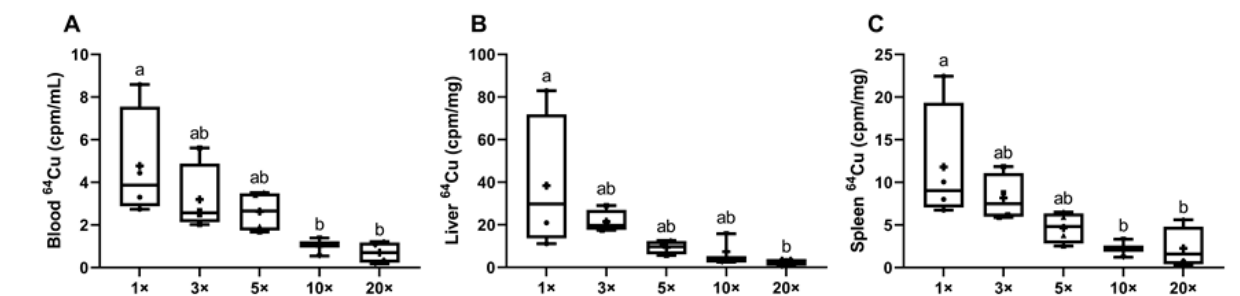
Figure 6. 64 Cu accumulation in blood, liver, and spleen were reduced in pups suckling dams that consumed diets with iron content in excess of requirements. 64 Cu activity in blood ( A ), liver ( B ), and spleen ( C ) from pups at 13–15 days of age suckling dams that consumed diets varying in iron concentration for ~3.5 weeks. One-way ANOVA analysis results are as follows: blood 64 Cu ( A ), p = 0.0153; liver 64 Cu ( B ), p = 0.0357; and spleen 64 Cu (C), p = 0.0174. When statistically significant differences were noted by one-way ANOVA, Tukey’s post hoc test was utilized to make comparisons between individual groups. Values without common superscript letters are statistically different from one another ( p < 0.05 ) ( A–C ). All data points are shown (for 2 male and 2 female pups), and mean values are indicated by “+” signs.